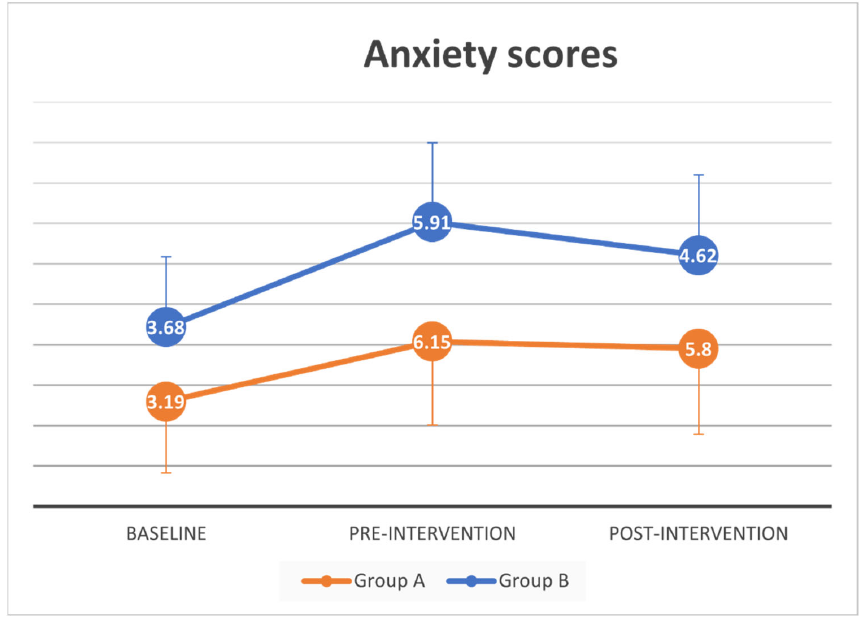
Geriatrics 2021 , 6 , x Figure 3. Anxiety scores at baseline, pre and post intervention. Figure 3. Anxiety scores at baseline, pre and post intervention.